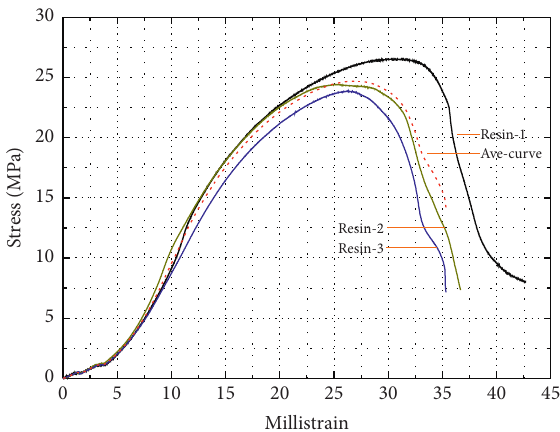
Figure 3: Strain-stress relationships for resin specimens R1 ∼ 3. Table 2: Mechanical parameters of the resin